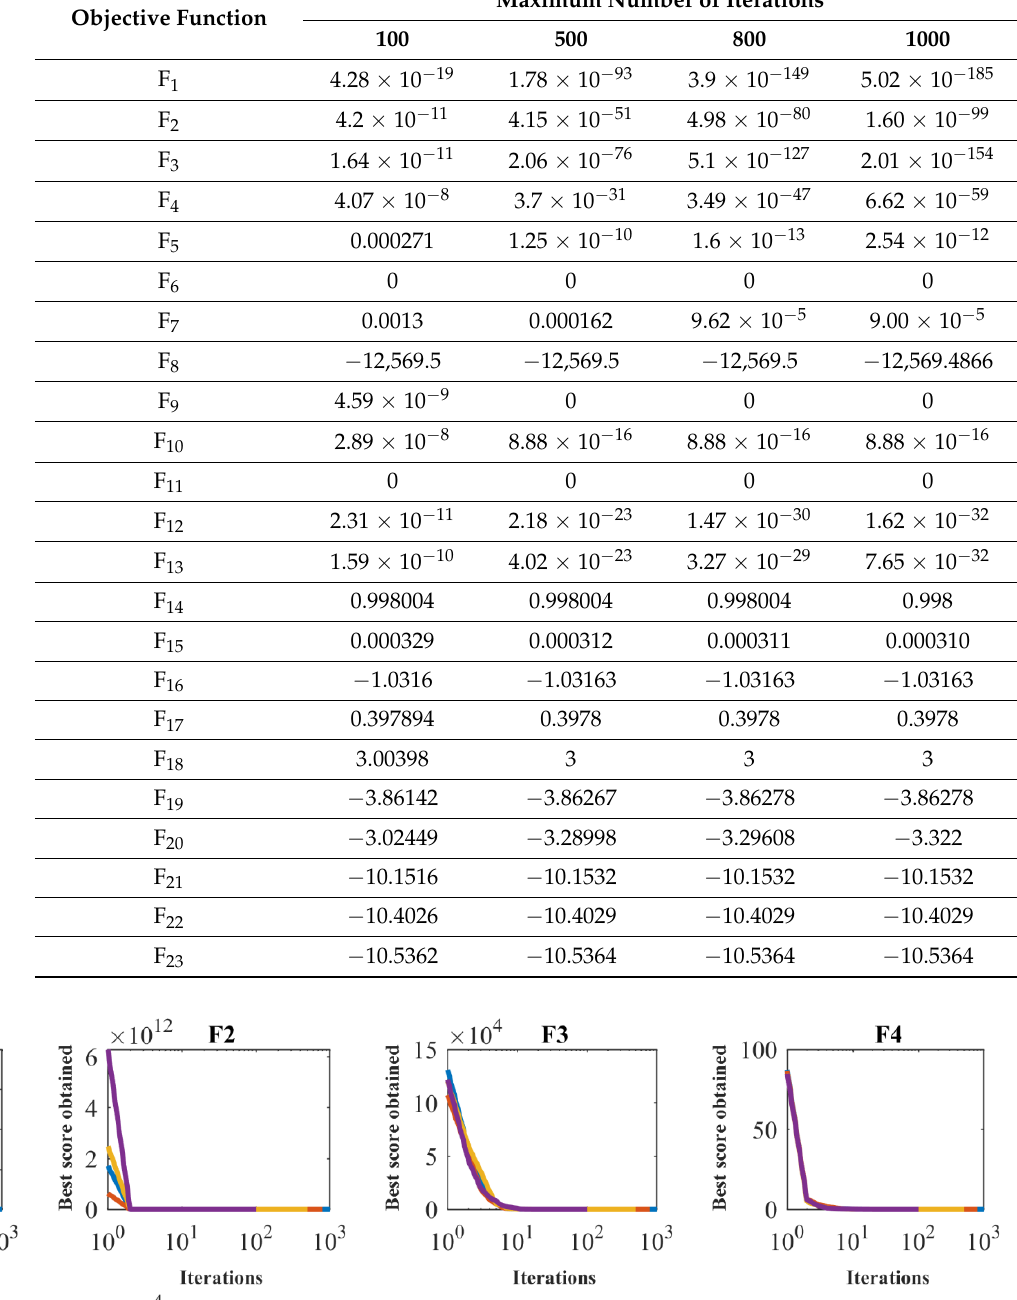
Table 7. Results of sensitivity analysis of SSVUBA to T .